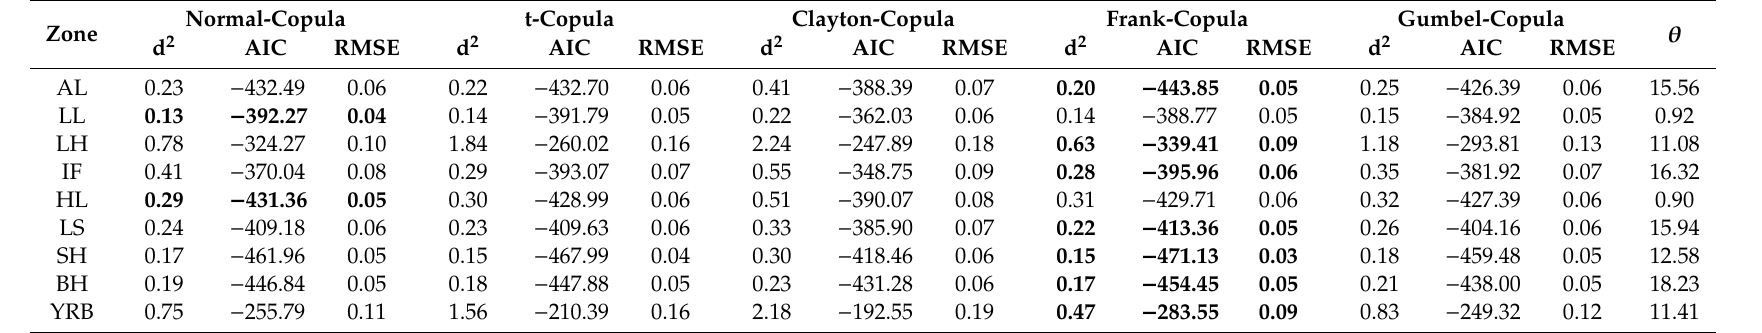
Table 4. Goodness of fit (GOF) evaluation of di ff erent Copula functions in the